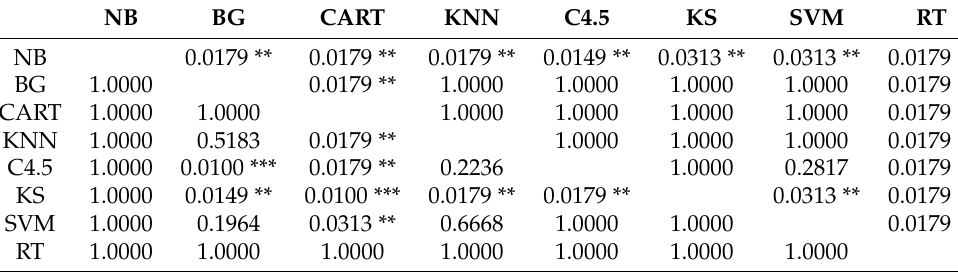
Table 24. Pairwise WSR test for AUROC of